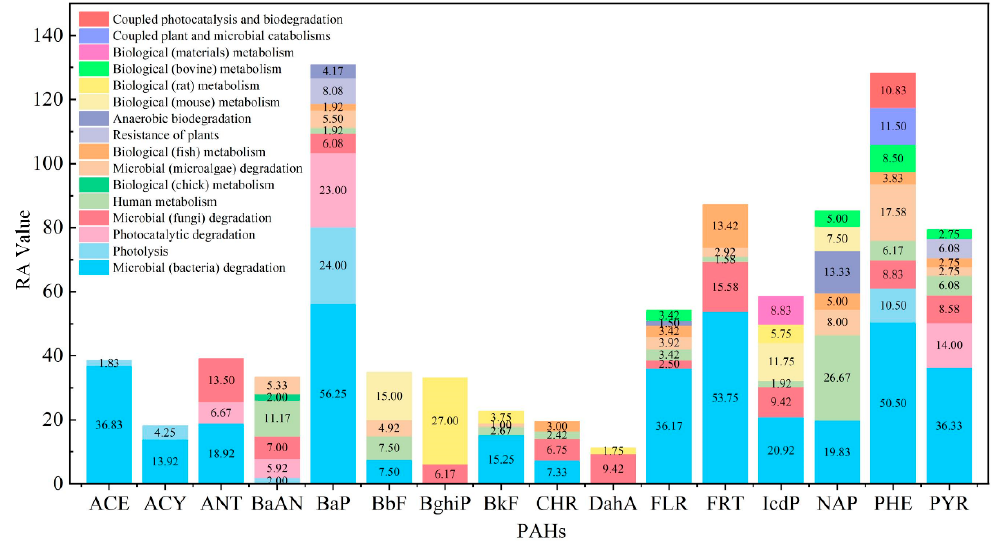
Figure 4. Total exposed risk evaluation value of degradation and transformation of